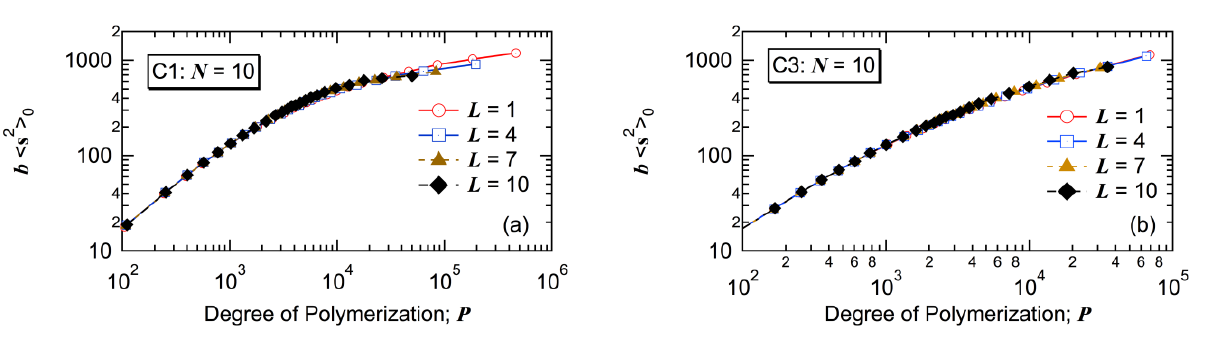
Figure 16. Relationship between the mean-square radius of gyration <s 2 > 0 and degree of polymerization P of the polymer molecules formed with N = 10: ( a ) C1 and ( b ) C3.